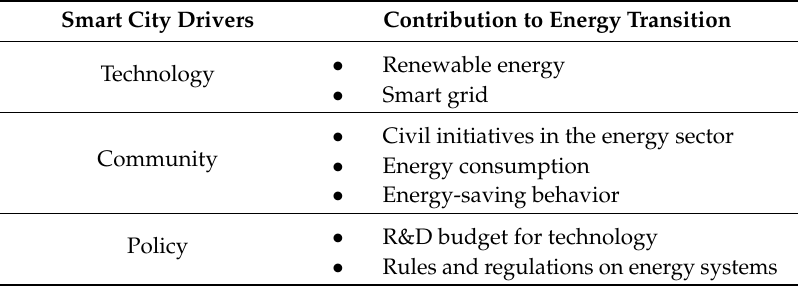
Table 2. Smart city drivers’ contribution to the energy